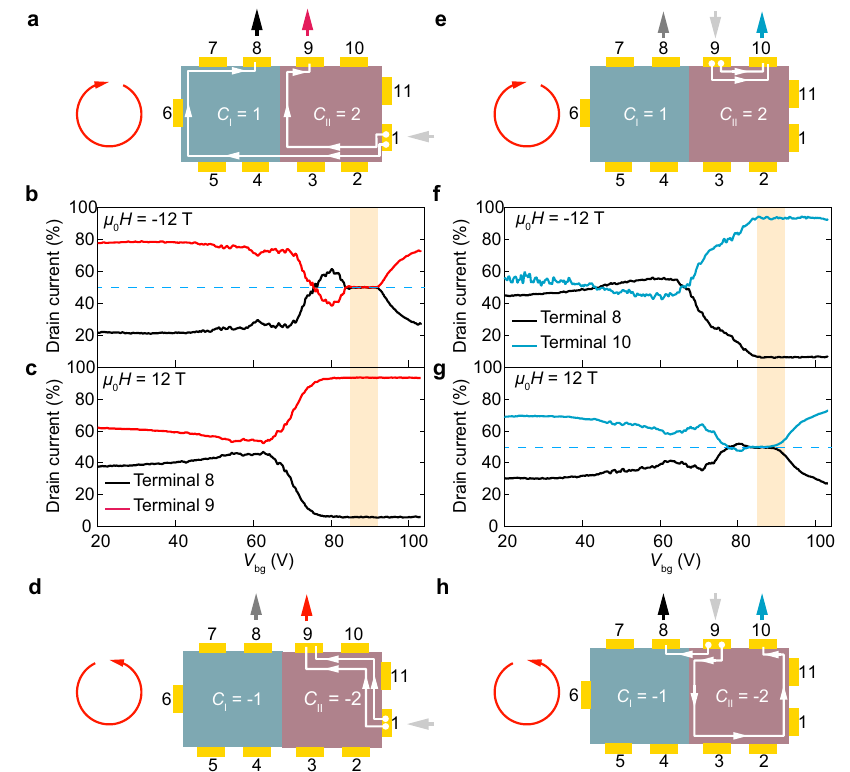
Fig. 2 | Detection ofchiral edge states at the Chern junction. a – d A bias current diagram. e – h Similar as ( a – d ) but with the bias current injected at contact 9 (source) and the drain current measured at contacts 8 (black) and 10 (blue) with of 2nA is injected at contact 1 (source) and the drain current is measured at con- other contacts fl oating. e Schematics for current fl ow through edge states at tacts 8 (black) and 9 (red) with other contacts fl oating. a Schematics for current µ fl ow through edge states at µ H = − 12T when C C H = − 12 T when C C 0 I =1 and II =2. b Drain current 0 I =1 and II =2. f Drain current normalized to the total current normalizedtothetotalcurrentasafunctionofbackgatevoltage V bg forcontacts8 versus V bg for contacts 8 and 10. g Same measurement as shown in ( f ) but at H =12T,and ( h ) isthe corresponding edge current fl ow schematics. Red circular µ and 9. Yellow shaded area denotes the gate range where Chern insulator junction 0 arrow denotes the chirality of the edge state, which is clockwise for negative forms and functions as a 1:1 current divider. c Same measurement as shown in ( b ) magnetic fi eld ( a and e ) and counterclockwise for positive fi eld ( d and h but performed at µ 0 H =12T, and ( d ) is the corresponding edge current fl ow